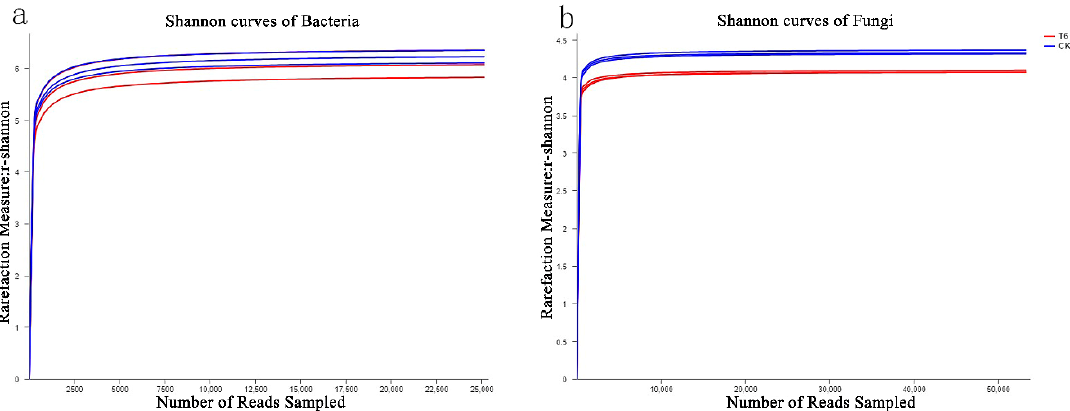
Figure 2. Shannon curves of communities of ( a ) bacteria and ( b ) fungi. Shannon curves, illustrating the influences of a dissimilarity cut-off of 3% on OTUs numbers uncovered in study groups. The T6-1 group consisted of poplar trees, which were exposed to bacterial zymotic fluid with T6-1. The CK group consisted of poplar trees, which were exposed to an equivalent volume of sterile zymotic fluid. We analyzed three replicates for every treatment. Table 4. Diversity along with richness indices of bacterial, as well as fungal communities from the two soil